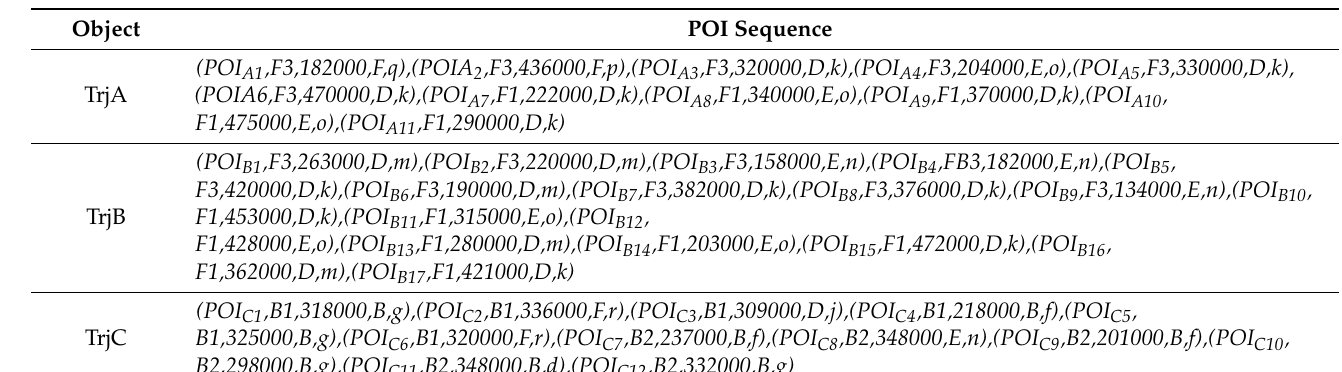
Table 6. Semantic trajectories of three